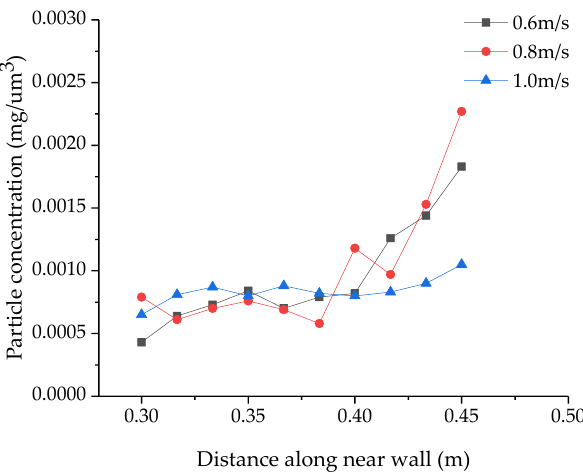
Figure 9. Average particle concentration near the wall.